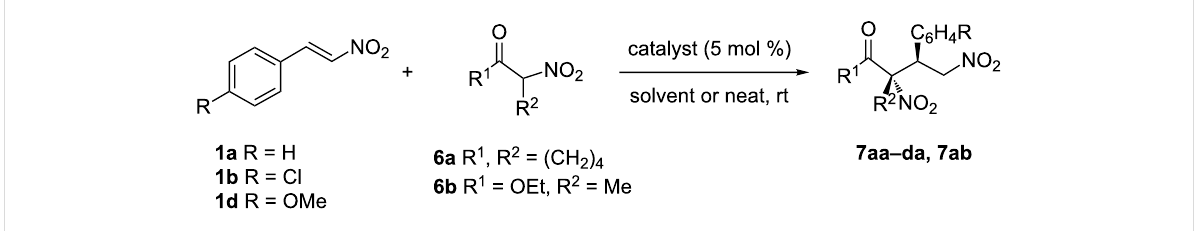
Table 4: Reactions of nitrostyrenes with α -nitrocyclohexanone and ethyl α -nitropropionate.